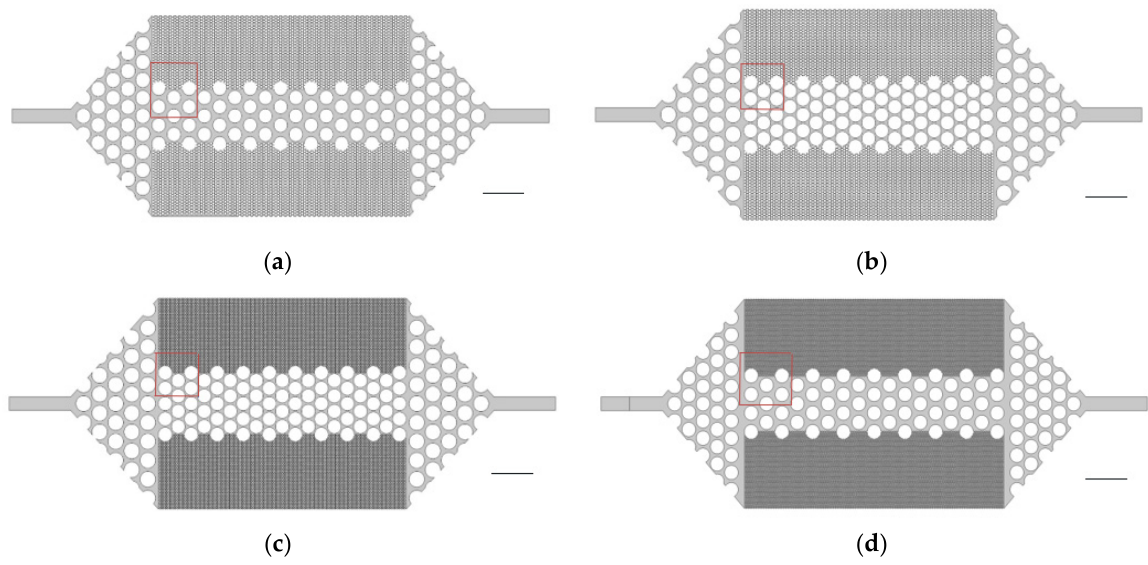
Figure 1. Geometric model diagram ( a ) is chip 1; ( b ) is chip 2; ( c ) is chip 3; and ( d ) is chip 4. The scale bar is 3 mm. Table 1. Summary of micromodel properties. Table 1. Summary of micromodel